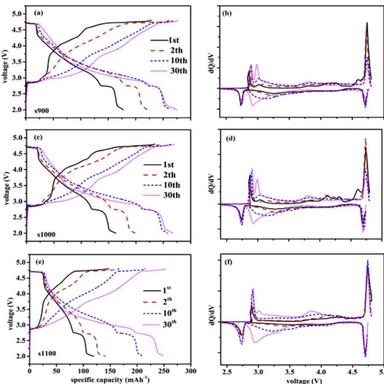
Voltage profiles and corresponding dQ/dV plots of (a and b) s900, (c and d) s1000, and (e and f) s1100, at 0.1C over a 2.0e4.8 V voltage window for the 1st, 2nd, 10th, and 30th cycles.